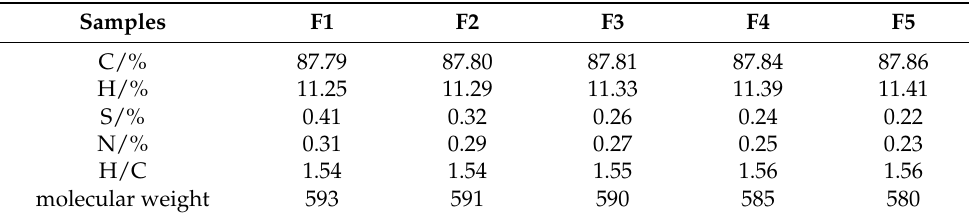
Table 2. Distribution of C/H/S/N elements in FCC slurry oil before and after hydrotreatment.